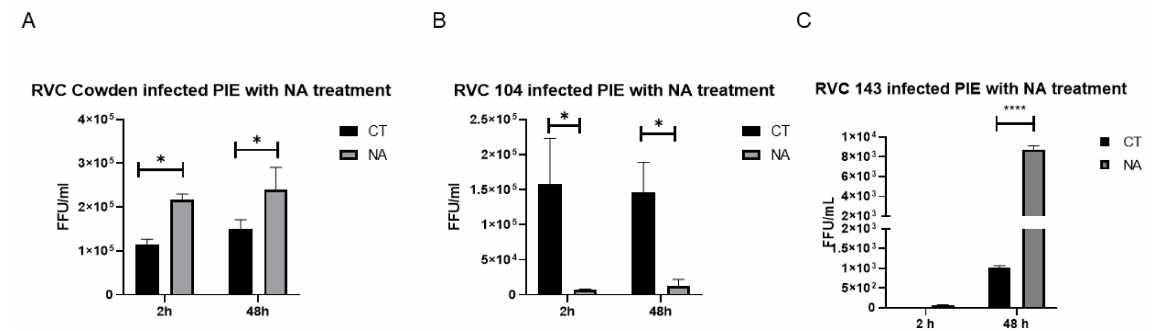
Figure 3. RVC replication in PIEs with or without sialidase treatment. Replication of virulent ( A ) Cowden, ( B ) PRVC104, and ( C ) PRVC143 after PIEs’ sialidase treatment, respectively. Differenti- ated PIEs were pre-treated with 10 mU sialidase (NA) from Arthrobacter ureafaciens or CT (TNC buffer) for 1 h at 37 ◦ C before inoculation. Then, PIEs were inoculated with 10 5 FFU of RVCs and incubated at 37 ◦ C. PIEs were harvested at 2 h and 48 h, and the virus titers were measured by RT-PCR. The error bars represent the standard deviation from triplicate samples. All infectivity assays were repeated independently at least twice. For p -value: * p < 0.05, **** p <